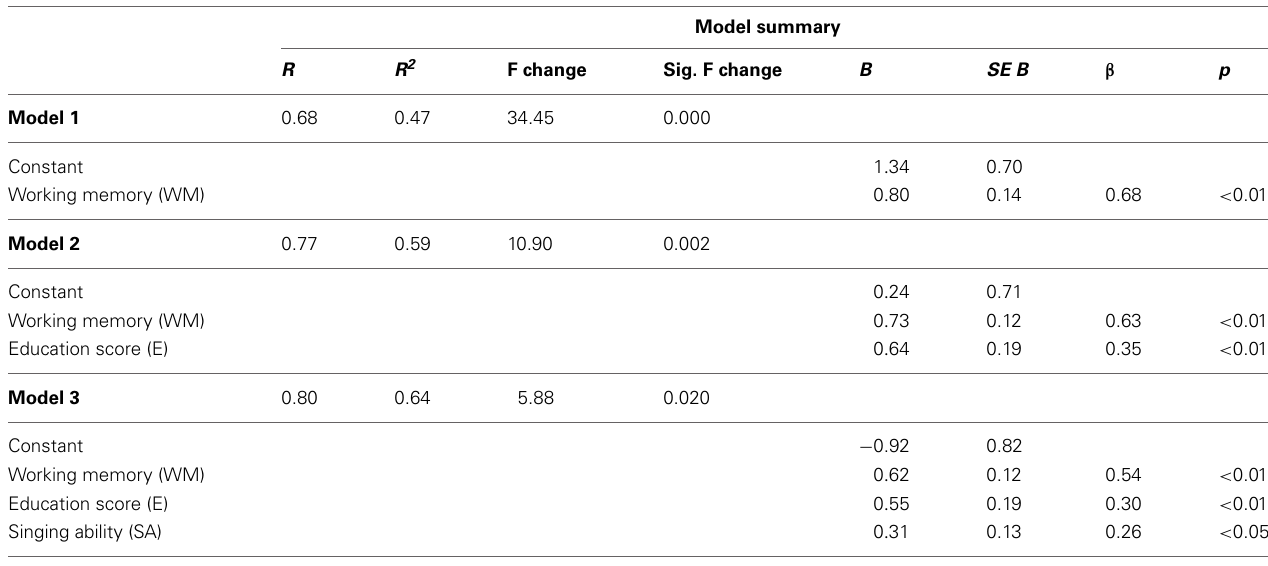
Table 2 | Multiple regression MLR